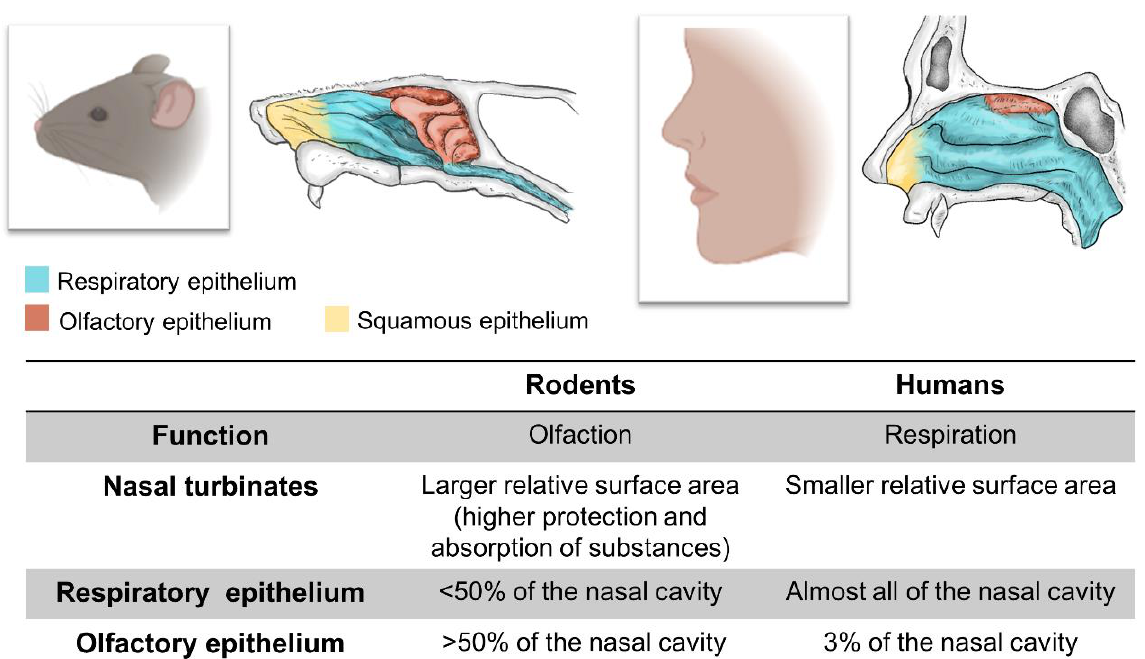
Figure 2. Comparison of the nasal atrium in rodents and humans, presenting the differentiating characteristics that may affect the efficacy of cell delivery to the CNS.